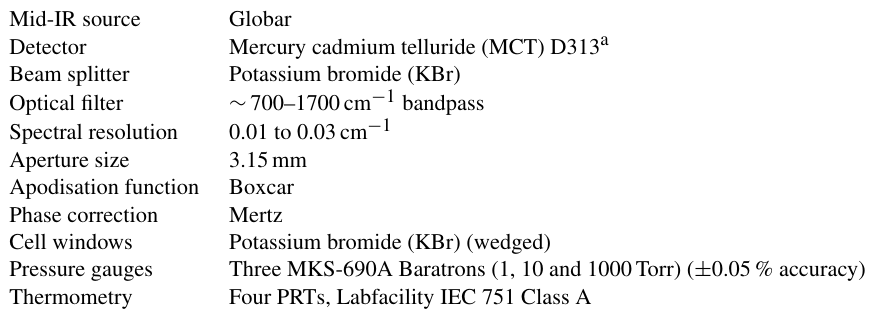
Table 1. FTS parameters and cell configuration for all measurements.